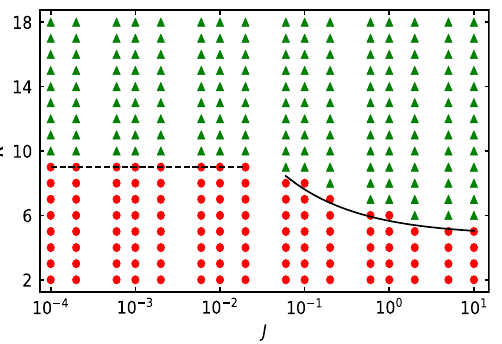
= 125 . Green (triangles) and red (circles) markers 0.05 and P κ space for M Figure 1. Phase diagram in J e = − denote MIPS and homogeneous phase respectively. Dashed and solid lines are the analytic expressions for the phase boundary, provided in Eq. (6) in the limit of small and large J ,